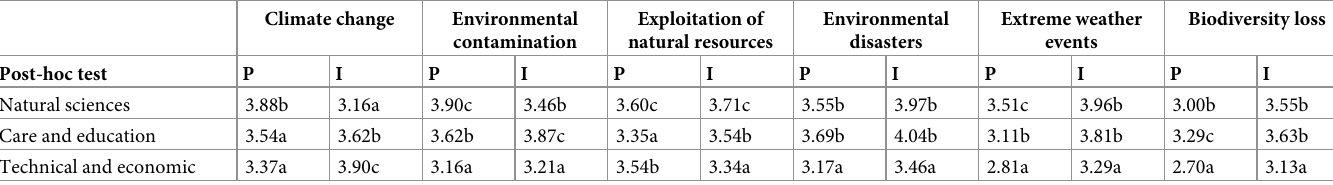
Table 4. Post-hoc test results confirming significant differences in average scores for individual fields of